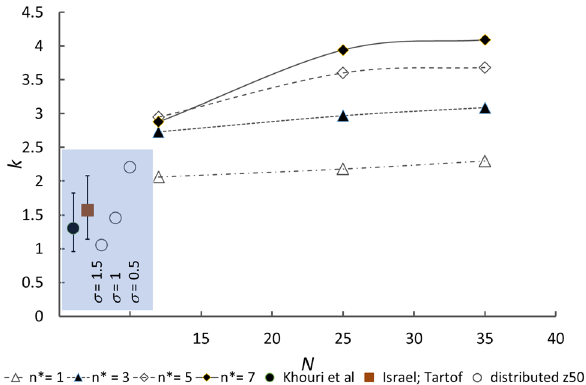
Figure 3. Rate parameter k of the log-logistic fit shown in Fig. 2 against number of spikes on the virus particle, for different threshold numbers of unoccupied spikes, n *. Symbols ○ : effect of introduction of a log-normal distribution of dimensionless concentration, z , equivalent to a distribution of neutralising antibody affinity, for spike number N = 25 and N − n * = 3; σ is the log-normal standard deviation of affinity. Black circle Comparison with the fit of Khouri et al. 10 describing vaccine efficacy as a function of neutralising antibody concentration, with their 95% confidence interval shown. Brown square Comparison with the fit of Fig. 1 (antibody concentration data of Israel et al. 14 and vaccine efficacy data of Tartof et al. 7 ) with 95% confidence interval from bootstrap